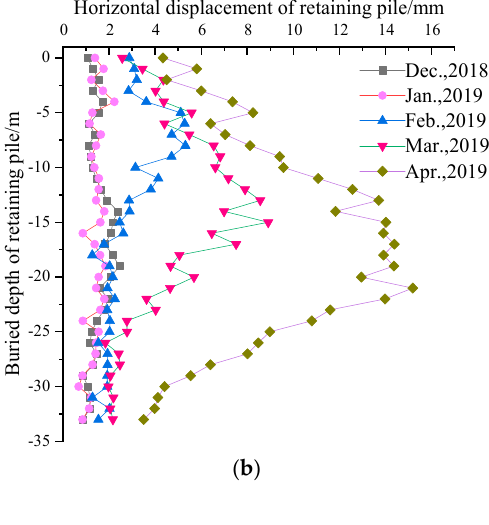
Figure 6. Time − history curve of the horizontal displacement of the pile top of the retaining pile. To further obtain the horizontal deformation law of the retaining pile in deep foundation pit excavation construction, the horizontal displacement monitoring data of the retaining pile at each time point of ZQT-4, ZQT-9, ZQT-15 and ZQT-21 in four directions and four measuring points in the southeast and northwest of the retaining pile are analyzed, as shown in Figure 7. The deformation trend of each retaining pile measuring point position at different excavation time nodes is large in the middle and small at both ends. With the passage of time, the maximum horizontal deformation position of the retaining pile gradually moves downward along the pile body. Comparing the pile displacement of the four measuring points at different construction times, it can be seen that the horizontal deformation of the ZQT-9 retaining pile on the south side of the foundation pit is slightly smaller than that on the north side of the ZQT-21 measuring point. The main reason is that the excavation interface of the north side of the foundation pit is large, and the contact surface between the retaining pile and the lateral active earth pressure is large during the excavation of the foundation pit, resulting in large deformation of the retaining pile on the north side. The retaining pile at measuring point ZQT-4 on the west side of the foundation pit is close to the side of the subway station, and the pile deformation is slightly smaller than that at measuring point ZQT-15 on the east side of the foundation pit. The main reason for the deformation of retaining piles is that the stiffness of subway station structure is large, and the disturbance of station structure caused by foundation pit excavation is far less than that of the stratum.